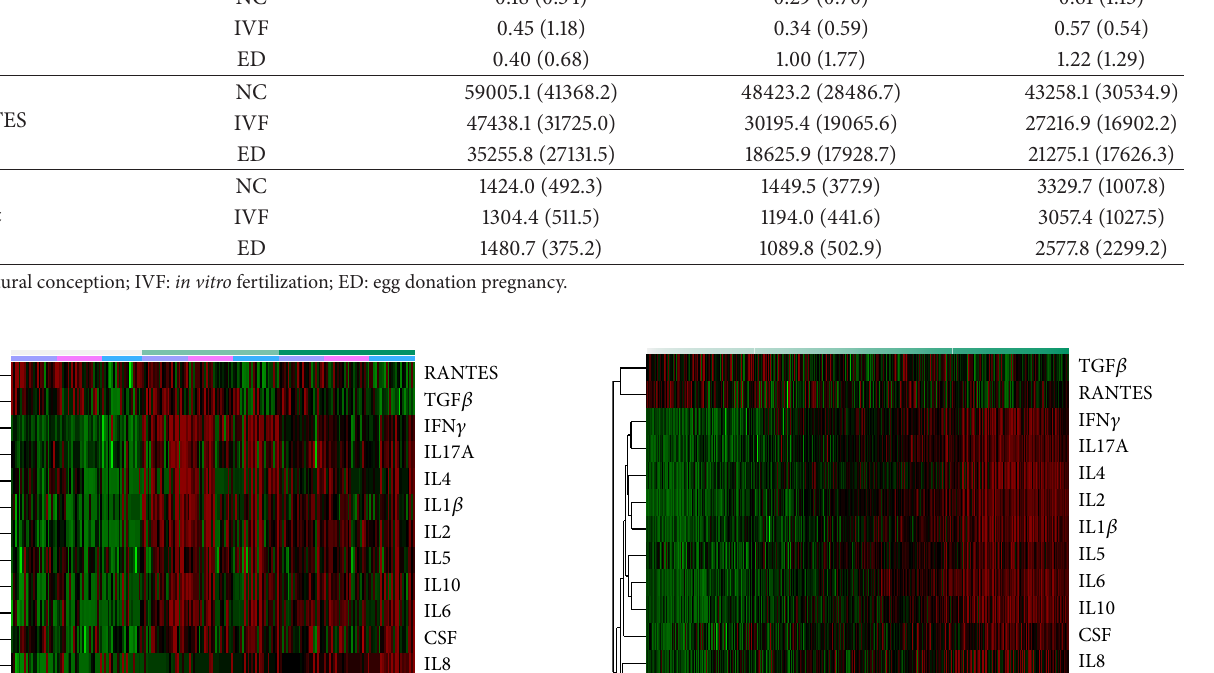
Table 2: Values of IL8, RANTES, and SDF1 𝛼 of the three study groups during pregnancy [mean (SD)]. Chemokine